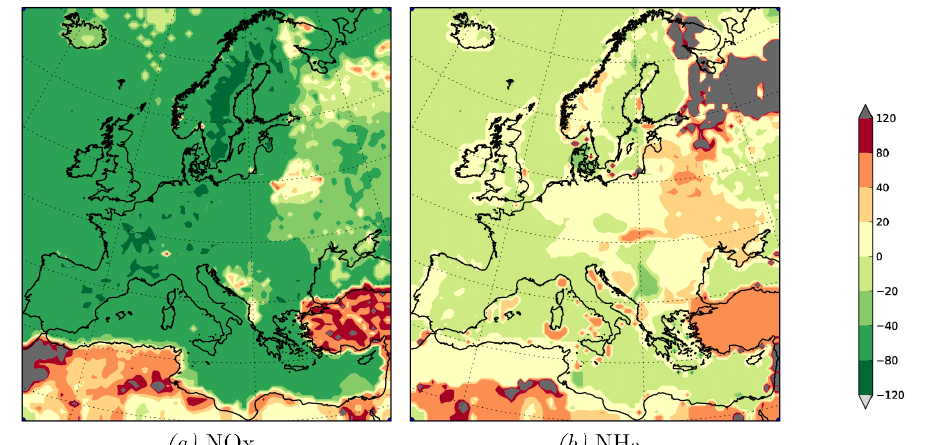
Figure 2. Emissions changes (%), 2005 to 2050, of NO x and NH 3